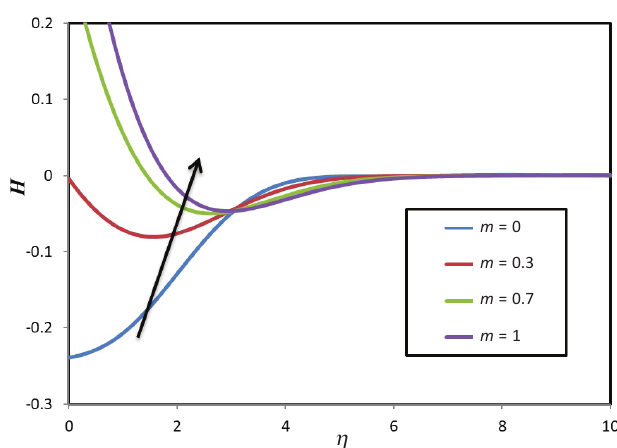
Fig. 8 – H (angular velocity) versus h for K = 0.5, I = 0.5, F = –0.5 (heat sink), Pr = 100 (weak polymers), Ec = 0.2, with m = 0 (Blasius flow), 0.3 (wedge), 0.7 (wedge), 1.0 (stagnation flow)